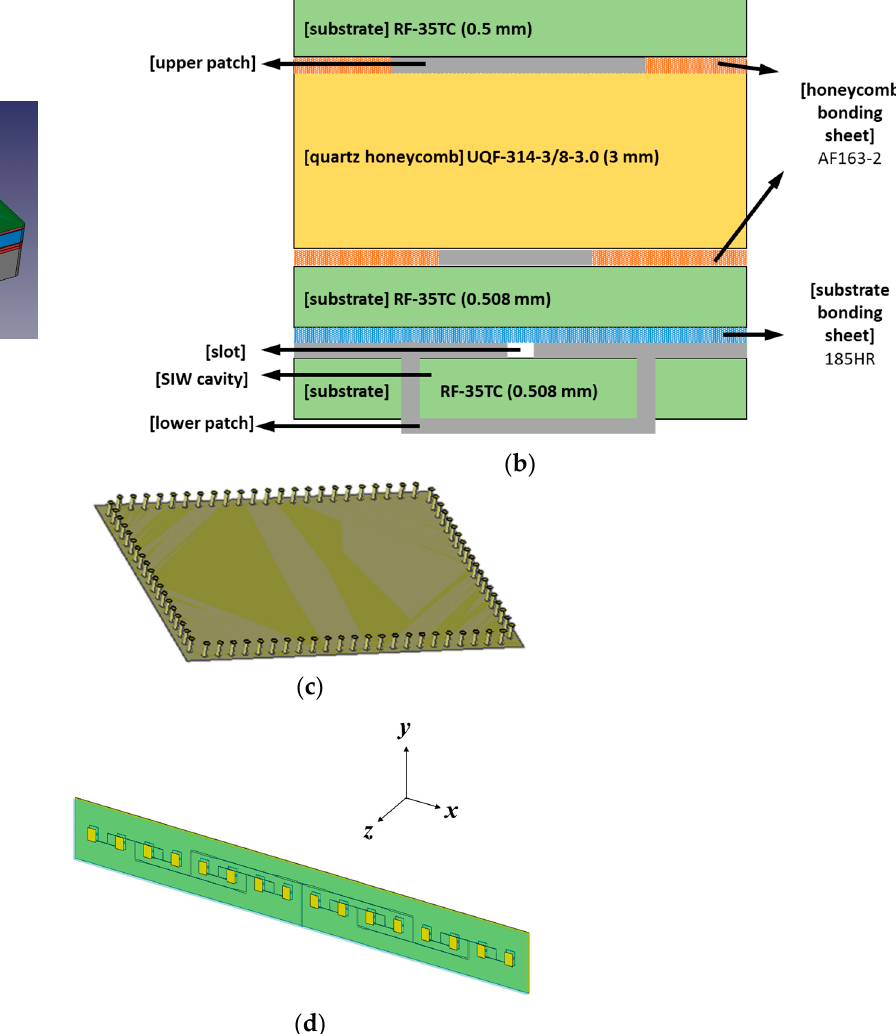
Figure 11. ( a ) Configuration of an element antenna, ( b ) sectional structure, and ( c ) SIW cavity of the radiating board, and ( d ) configuration of a 1 × 16 subarray of the S-STEP SAR antenna.